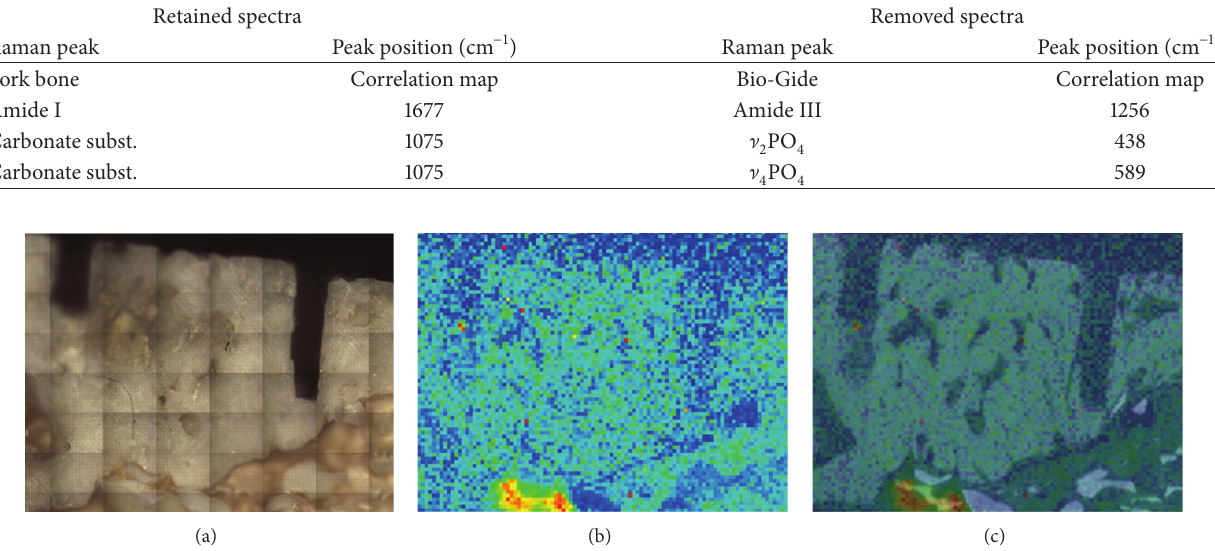
Figure 2: (a) Microscopic image, (b) Raman image showing the intensity distribution of the Amide III band, and (c) Raman image overlapped with the 𝜇 -CT image.